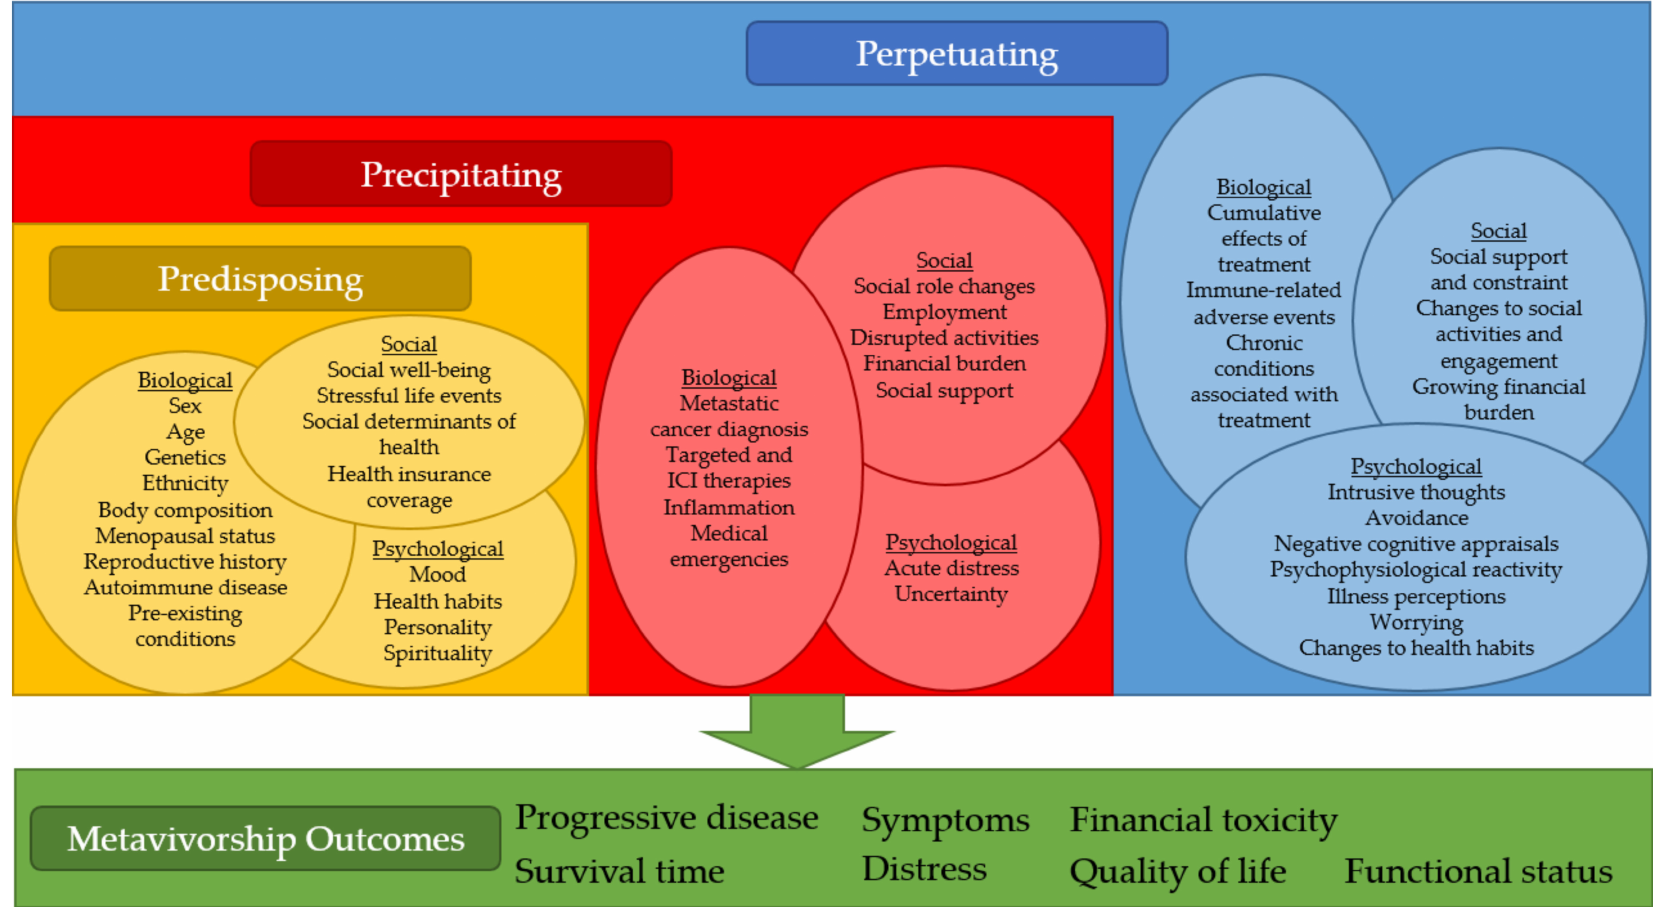
Figure 2. Biopsychosocial Predisposing, Precipitating, and Perpetuating (3P) Factors and Metavivorship